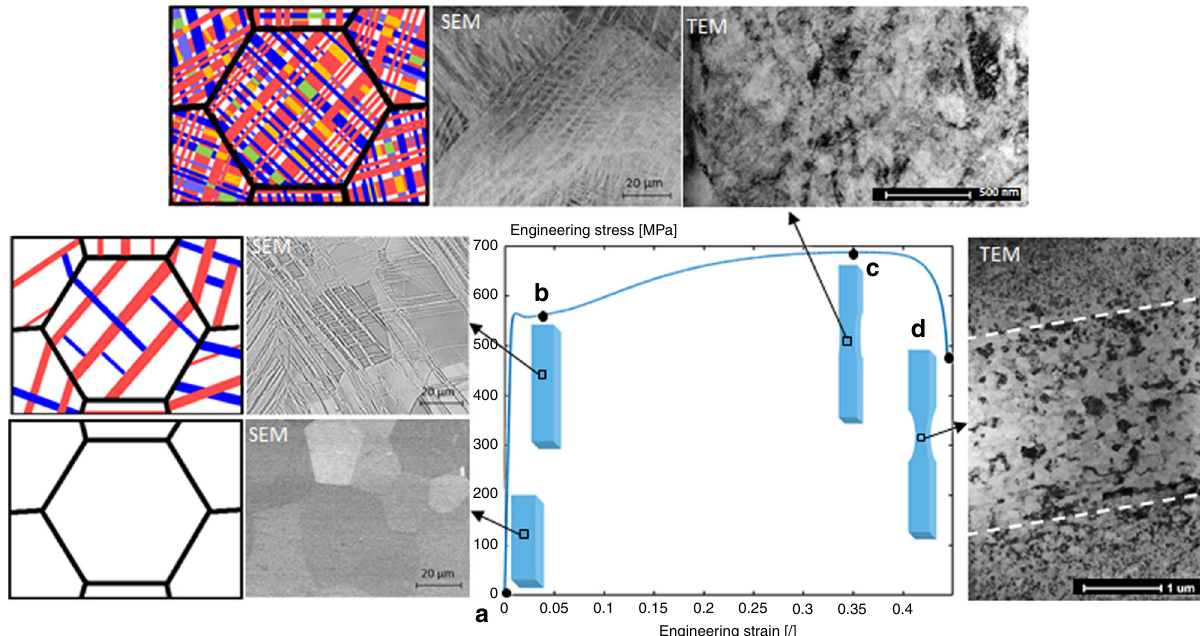
Fig. 3 Evolution of the microstructure during deformation. a The initial microstructure is constituted of equiaxed grains 40 ± 9 µ m in size. b At a true strain of 0.05, several deformation “ bands ” are formed within the grains during deformation resulting from the simultaneous activation of the TRIP and TWIP effects. c At necking, the density of deformation “ bands ” is very large, with multiple secondary deformation “ bands ” formed in the primary ones. A TEM micrograph shows that the microstructure is constituted by nanoblocks about 50 – 100 nm size containing a huge density of dislocations. d At a deformation level close to the fracture strain, the microstructure is further re fi ned together with larger equiaxed grains in the localized shear bands, indicated in the fi gure by white dashed